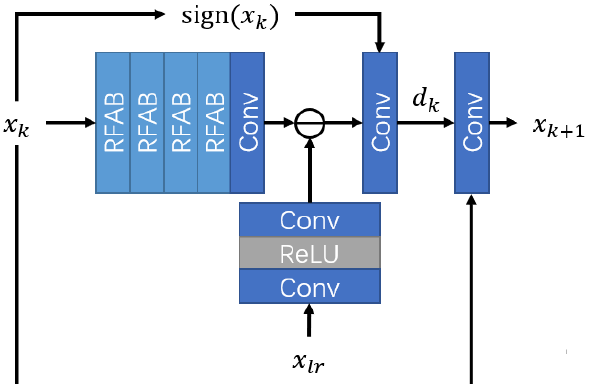
Figure 2. Block design of the LASSO